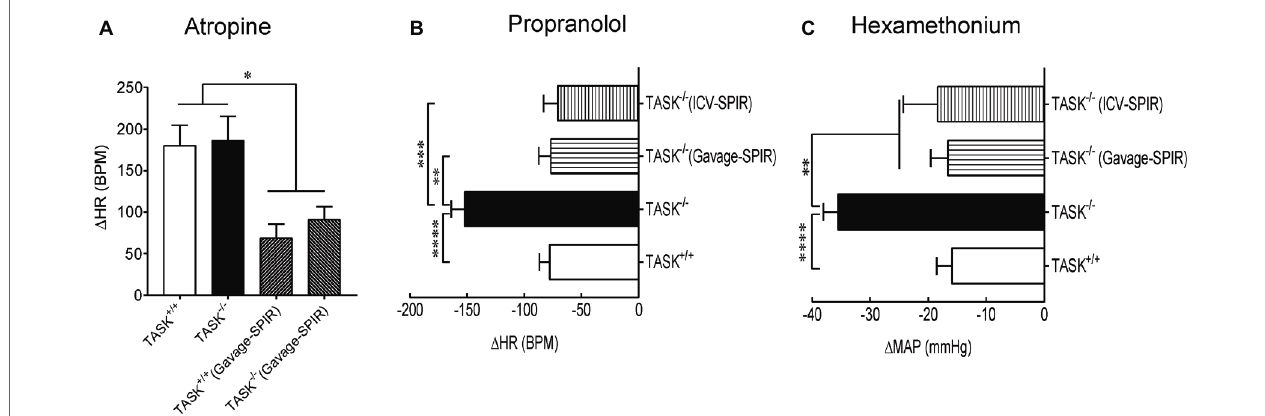
FIGURE 5 | Sympatho-vagal imbalance in TASK − / − mice. (A) The tachycardiac response to atropine ( Δ HR) was similar between TASK +/+ ( n = 9) and TASK − / − mice ( n = 7). Systemic blockade of MRs similarly inhibited the tachycardiac response to atropine in two genotypes ( n = 5 for TASK +/+ ; n = 8 for TASK − / − ). (B) The bradycardiac response to propranolol ( Δ HR) was greater in TASK − / − mice ( n = 23) compared to TASK +/+ mice ( n = 19). Either oral gavage ( n = 7) or ICV injection ( n = 8) of SPIR significantly diminished the propranolol-stimulated bradycardiac response in TASK − / − mice. (C) The decrease in mean arterial pressure ( Δ MAP) by a ganglion blockade with hexamethonium was greater in the TASK − / − ( n = 20) versus TASK +/+ ( n = 16) mice. Such effects were remarkably compromised after either systemic ( n = 7) or central ( n = 8) application of SPIR. * p < 0.05, ** p < 0.01, *** p < 0.001, **** p < 0.0001 as indicated by one-way ANOVA with Tukey’s multiple comparisons